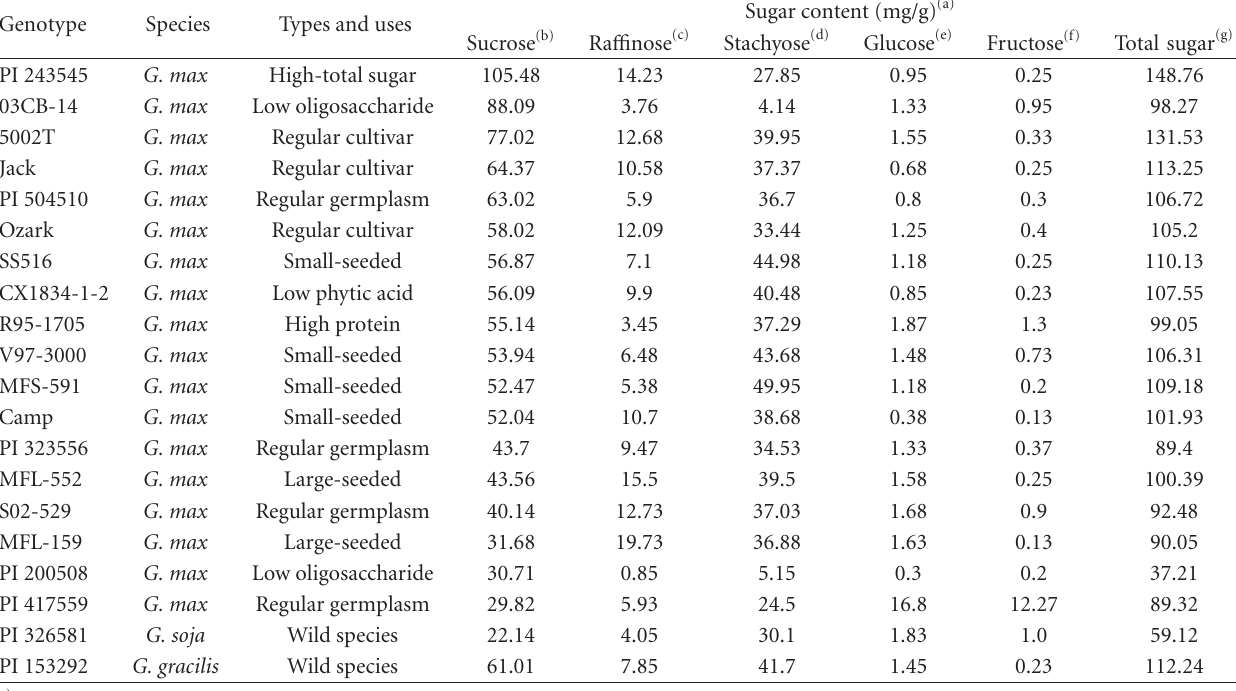
Table 1: List of soybean genotypes used in this study and detected mean sugar